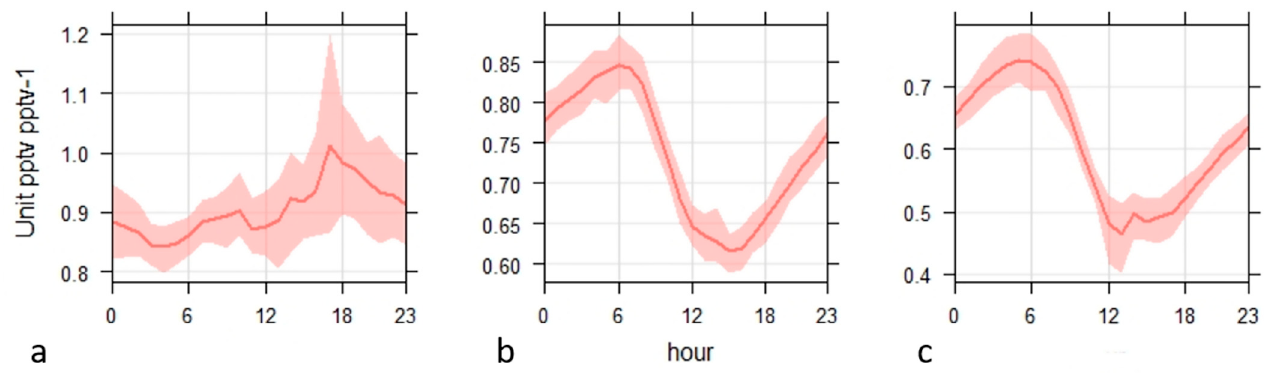
Figure 6. Diurnal variations in MP/E ratio ( a ) before, ( b ) during, and ( c ) after the lockdown.